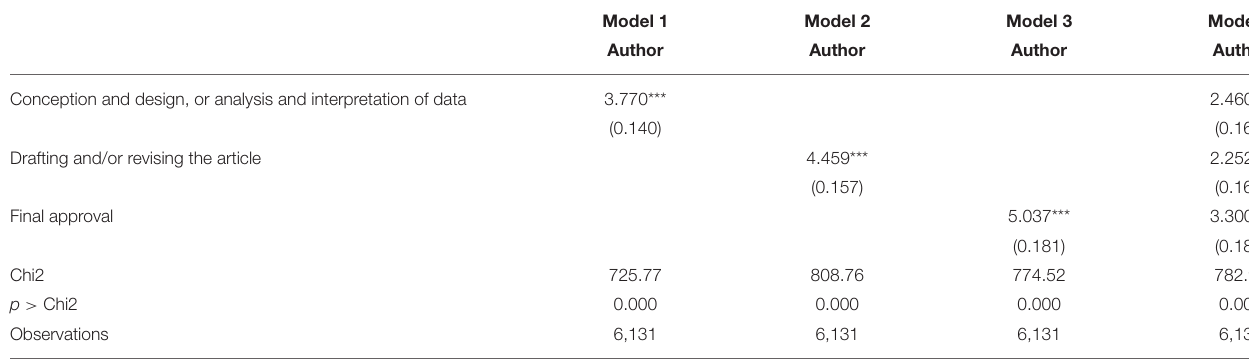
TABLE 5 | Effects of vancouver criteria on